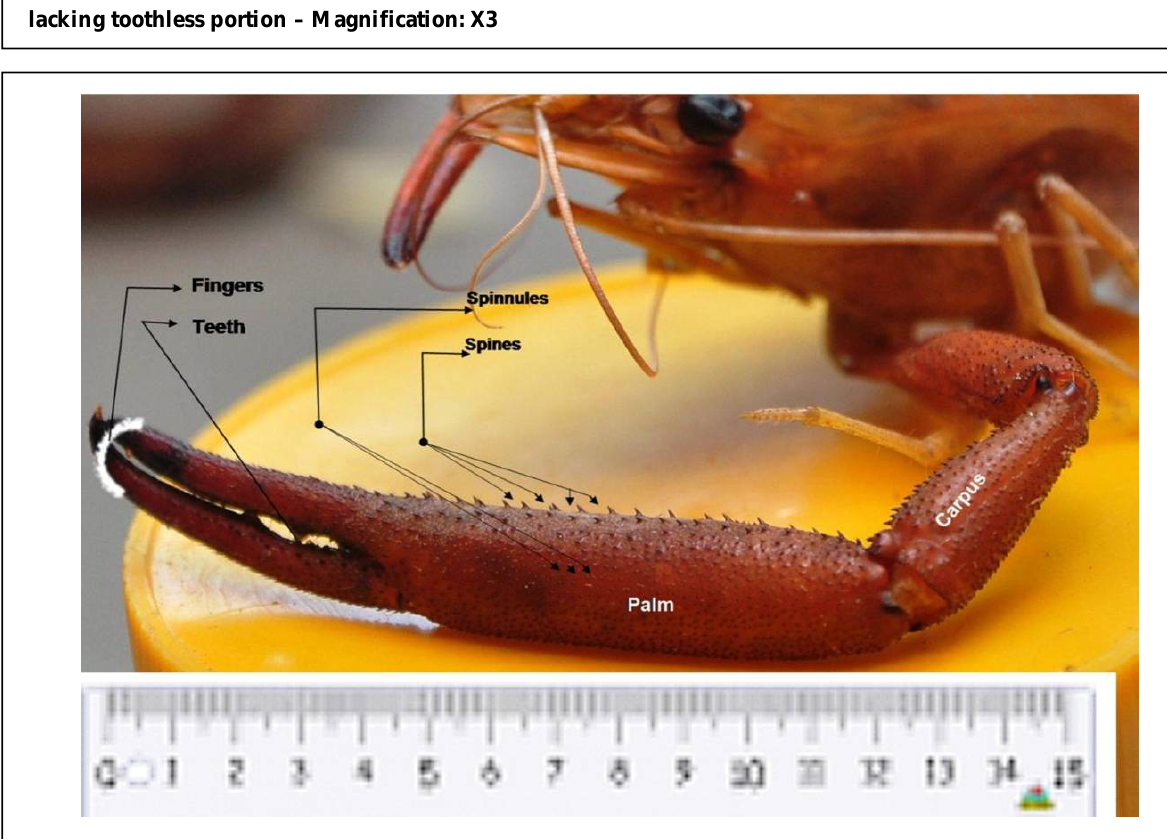
Plate 2: Left chelae of M. vollenhovenii showing teeth on the inner part of the finger, presence of spines and spinules on the palm, carpus and merus – Magnification: